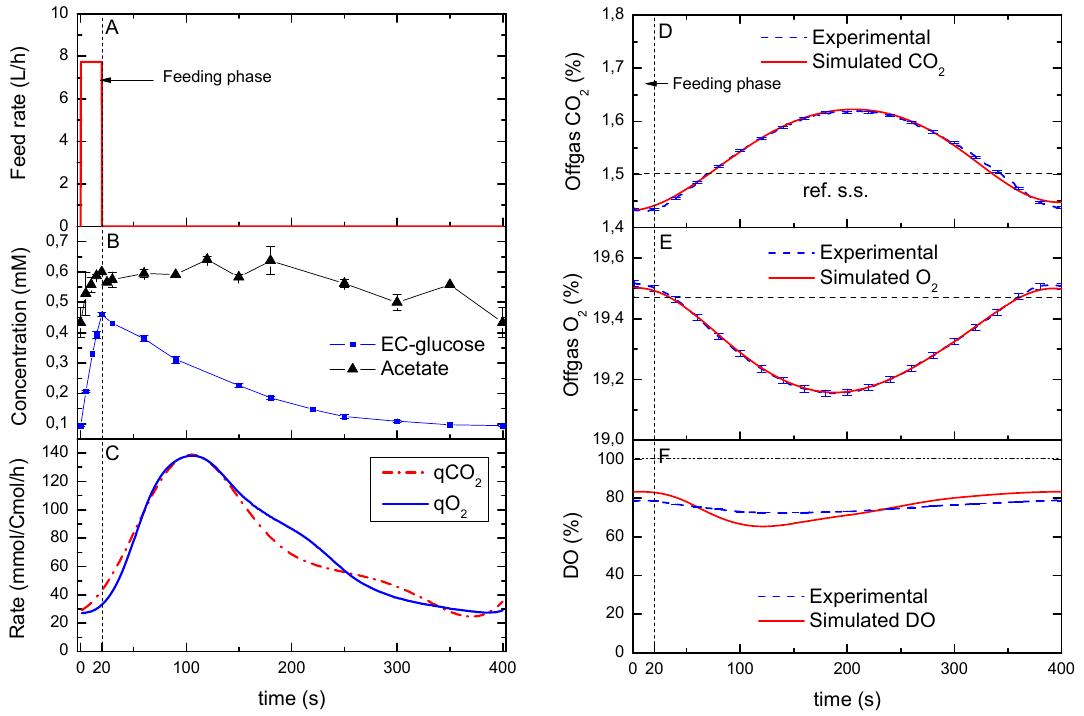
Figure 1. ( A ) Feeding rate during one cycle; ( B ) Measured extracellular concentration of glucose (EC-glucose, squares) and acetate (triangles), error bars represent the standard error of duplicate determination during two subsequent cycles. ( C ) Model-based estimation of the qO and qCO ; ( D – F ) Dynamics of the on-line measurements (off-gas CO 2 2 DO, dissolved oxygen) during one cycle in comparison to the model simulation (using the rates in C). The horizontal dashed line in D and E represents the reference steady state. The vertical dotted line represents the end of the feeding